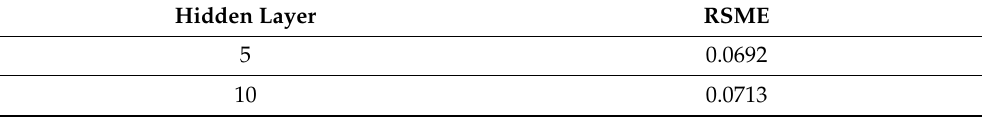
Table 19. Root mean squared error (RMSE) values based on the number of hidden layers.